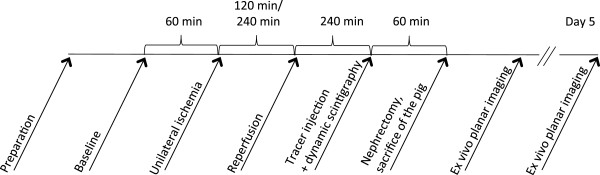
Experimental protocol.